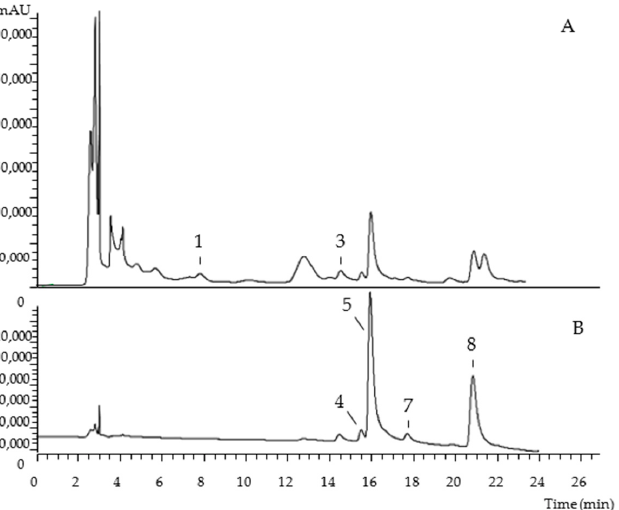
Figure 2. Algerian ‘Gold Nugget Pumpkin’ peel chromatogram, recorded at 280 nm ( A ) and 370 nm ( B